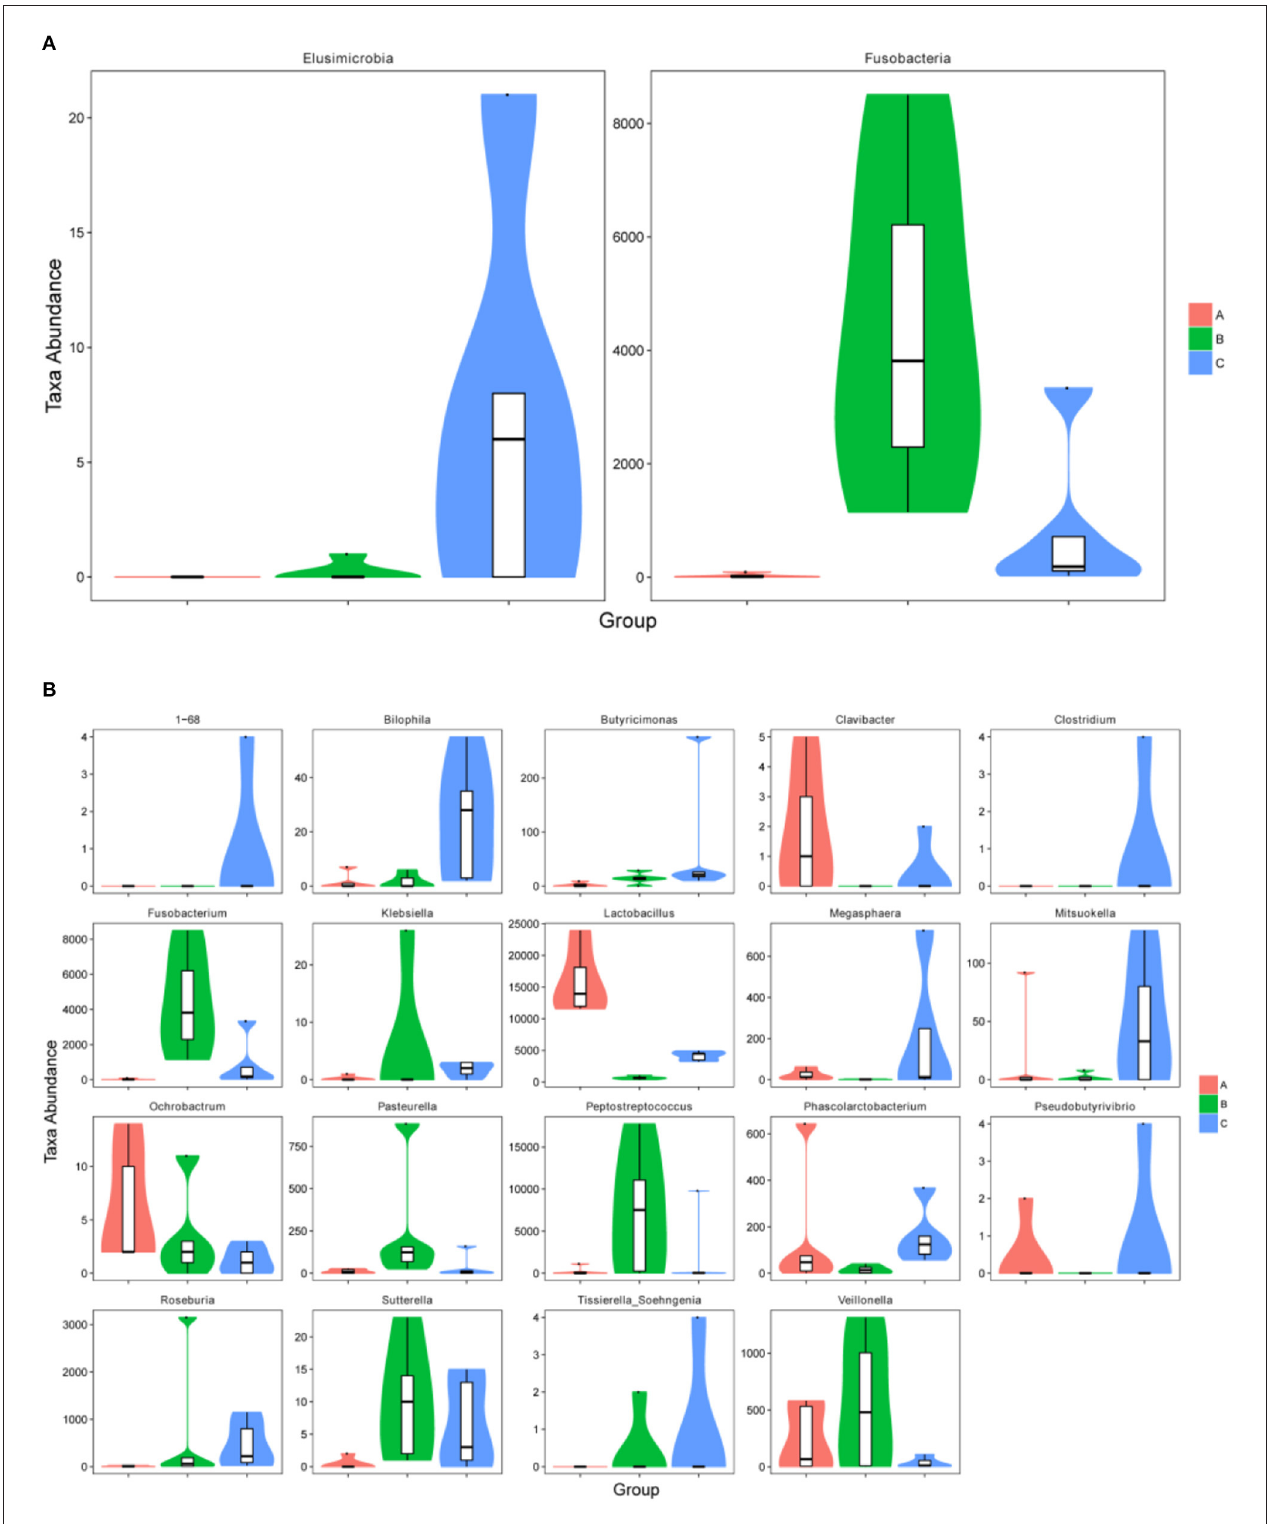
FIGURE 5 | The metastatic composition of microbial diversity. (A) Microbial diversity at phylum level, (B) microbial diversity at genus level. A: Healthy piglets; B: Diarrheal piglets; C: Treated piglets.